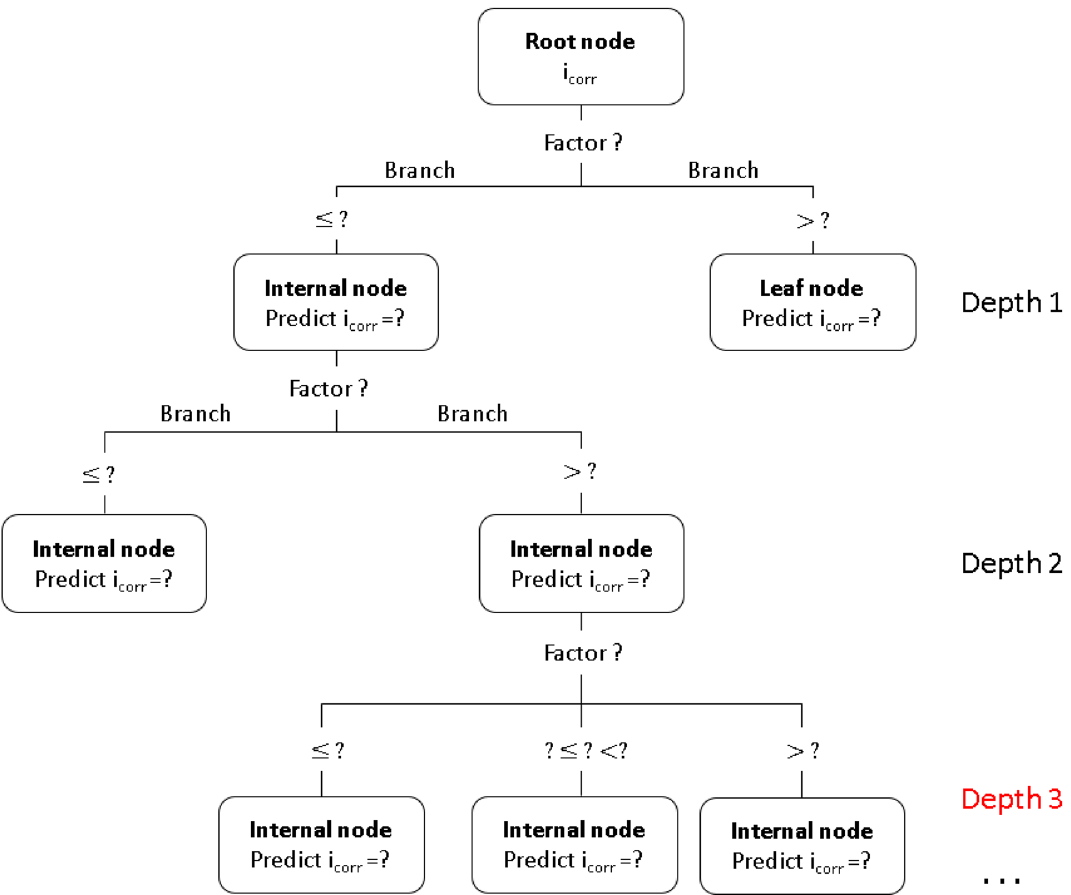
Figure 10. Simple decision tree structure for predicting external corrosion rate of carbon steel in